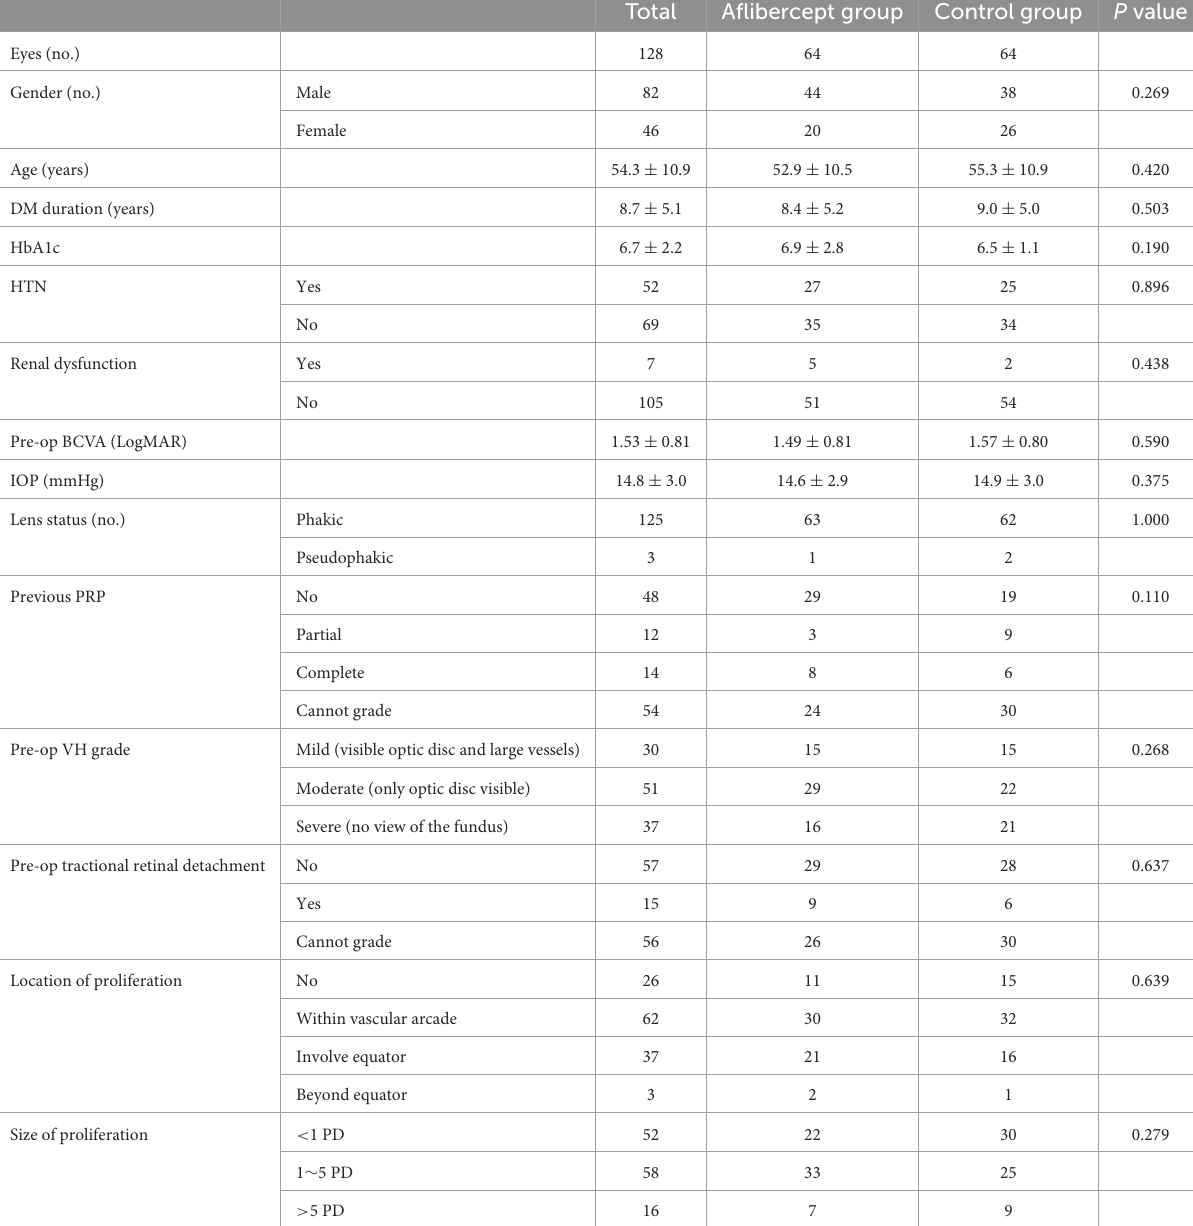
Total Aflibercept group Control group P value